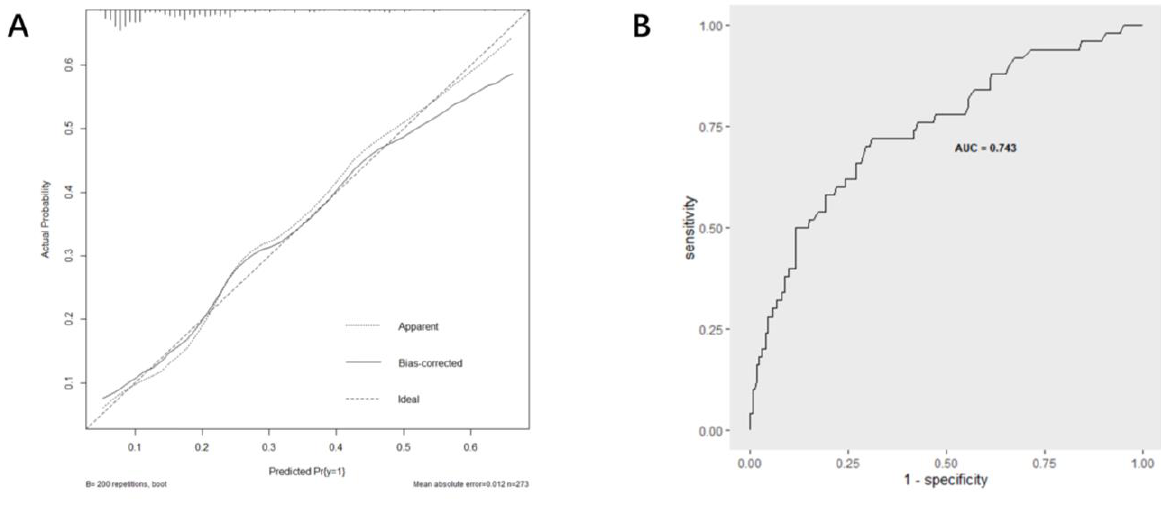
Figure 4. Evaluation of the predictive performance using calibration curve ( A ) and ROC curve ( B ).